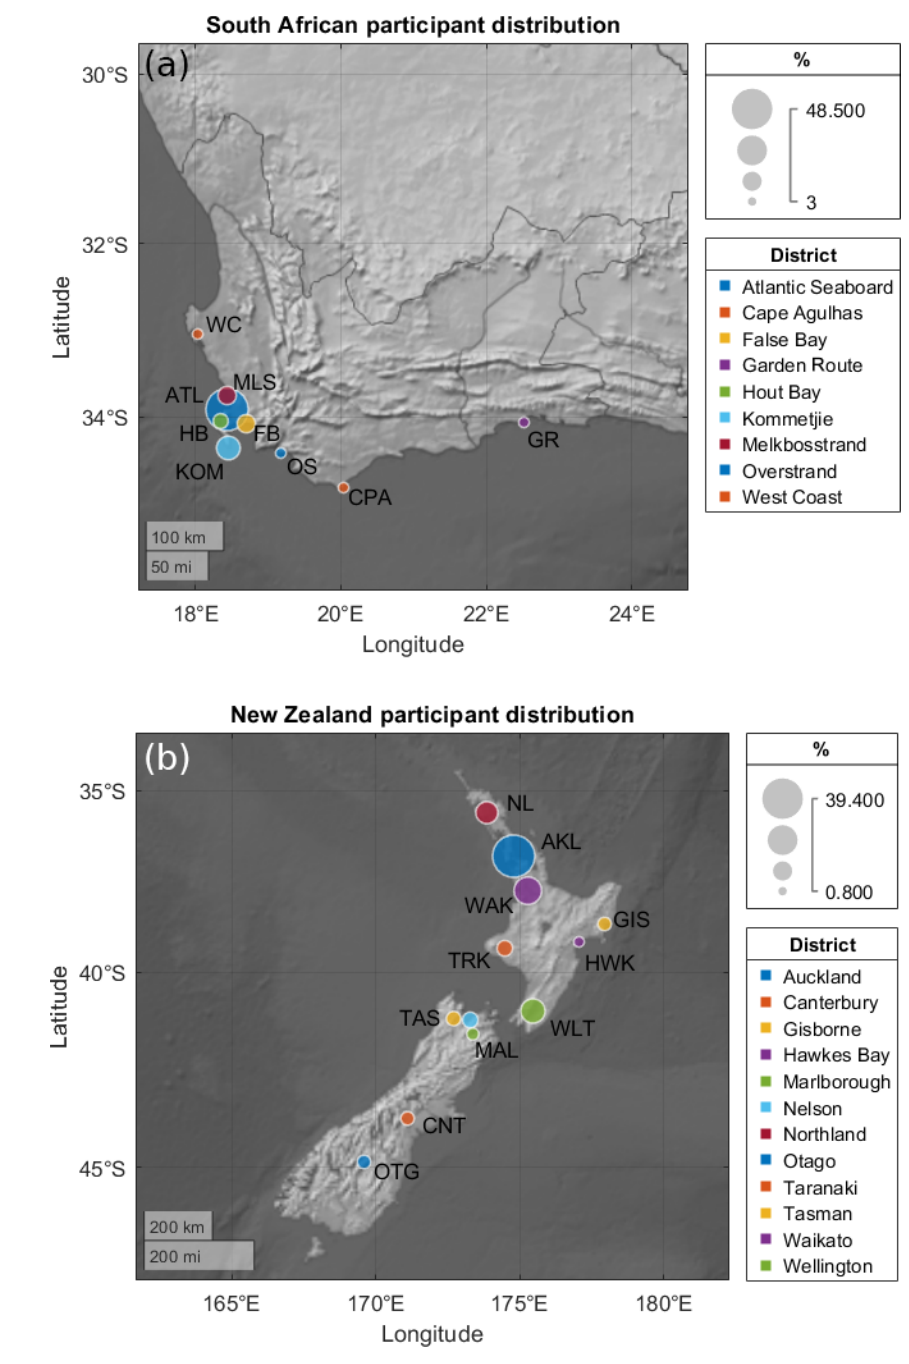
Figure 3. (a) South African and (b) New Zealand participant